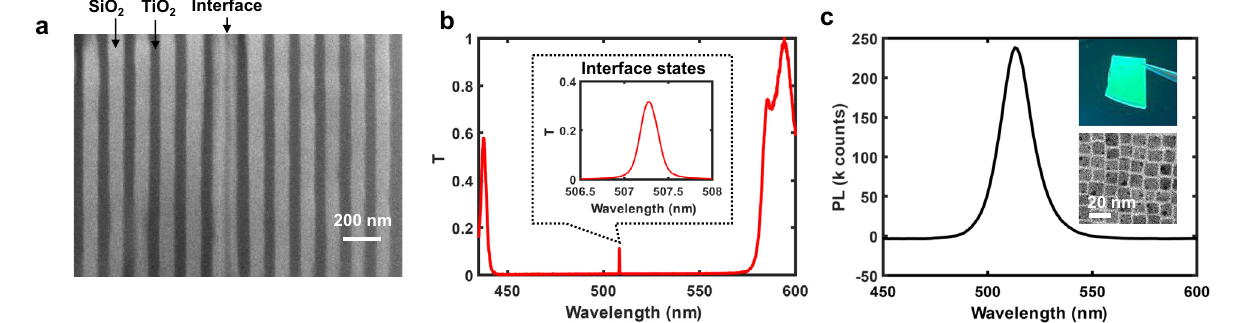
Fig. 3 | Topological microcavity and gain medium. a Cross-sectional scanning electronmicroscope(SEM)imageofthe1Dmicrocavityconsistingof20alternating layers of TiO 2 and SiO 2 and on eachside of the interface. b Measured transmission spectrum of the 1D topological cavity. The high-Q transmission peak (Q~2000) at 507.3nm, arising from the interface state, is magni fi ed in the inset. c